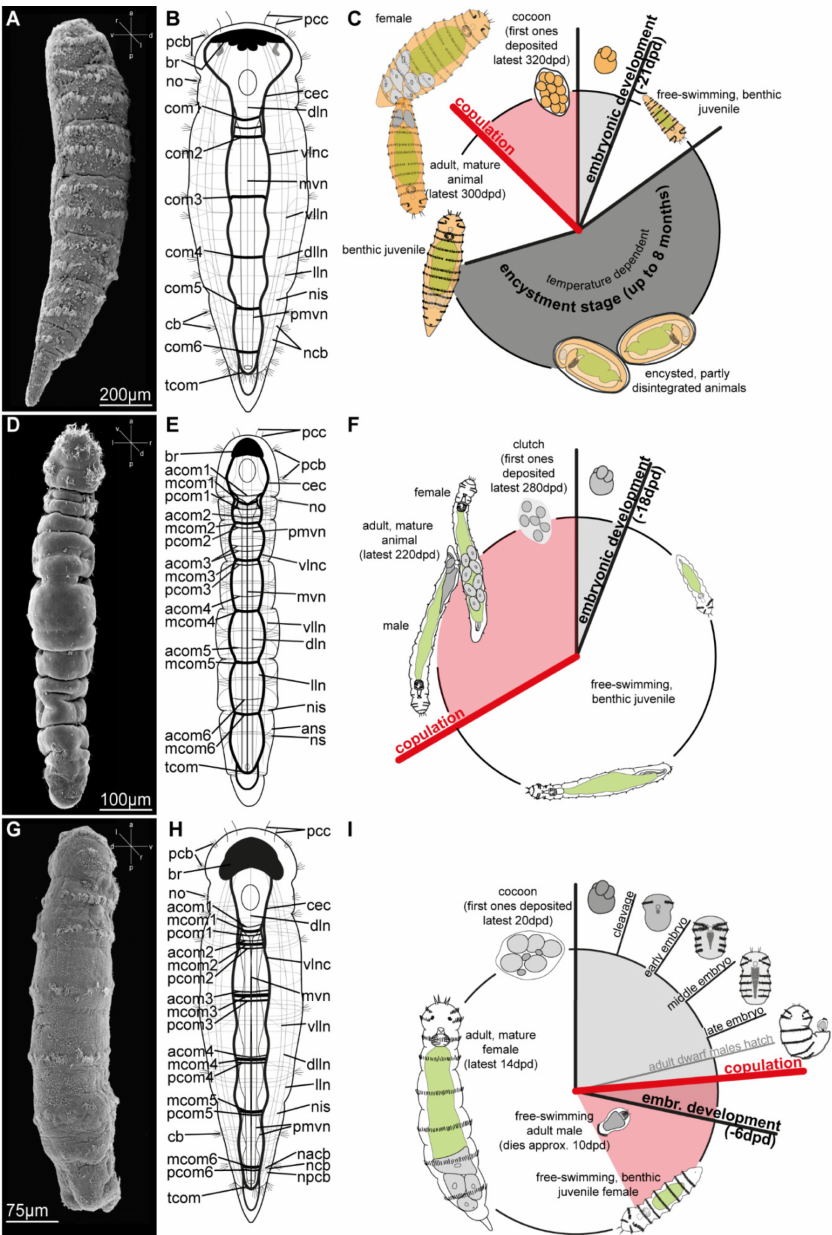
Figure 4. General external morphology, nervous system architecture and life cycle pattern of representatives of each of the three genera within Dinophilidae. ( A – C ). Dinophilus vorticoides (Faroe Islands); ( D – F ) Trilobodrilus axi (Sylt, Germany), ( G – I ) female Dimorphilus gyrociliatus . ( A , D , G ) Scanning electron micrographs illustrating external ciliation patterns (small crosshairs indicating orientation); ( B , E , H ) schematic reconstruction of the nervous system based on immunohistochemical labelling with anti-acetylated α -tubulin and confocal laser scanning microscopy (CLSM) in ventral view; ( C , F , I ) schematic summary of the life cycles of D. vorticoides , T. axi and D. gyrociliatus based on literature review and personal observations, developmental time given in days post deposition (dpd). Abbreviations: a, anterior; acom, anterior commissures; ans, angled segmental nerve; br, brain; cb, ciliary band; cec, circumesophageal connective; com, commissure; d, dorsal; dlln, dorsolateral longitudinal nerve; dln, dorsal longitudinal nerve; drcc, dorsal root of the circumesophageal connective; l, left; lln, lateral longitudinal nerve; mcom, median commissure; mvn, medioventral nerve; nacb, nerve anterior to the ciliary band; ncb, nerve of the ciliary band; nis, intersegmental nerve; no, nuchal organ; npcb, nerve posterior to the ciliary band; ns, segmental nerve; p, posterior; pcb, prostomial ciliary band; pcc, prostomial compound cilia; pcom, posterior commissure; pmvn, paramedian nerve(s); r, right; tcom, terminal commissure; v, ventral; vlln, ventrolateral longitudinal nerve; vlnc, ventrolateral nerve cord. Images modified from